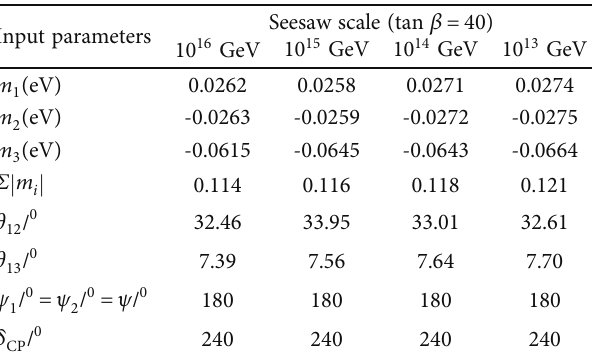
R Þ with = q × ð θ + θ 23 13 12 scale. s